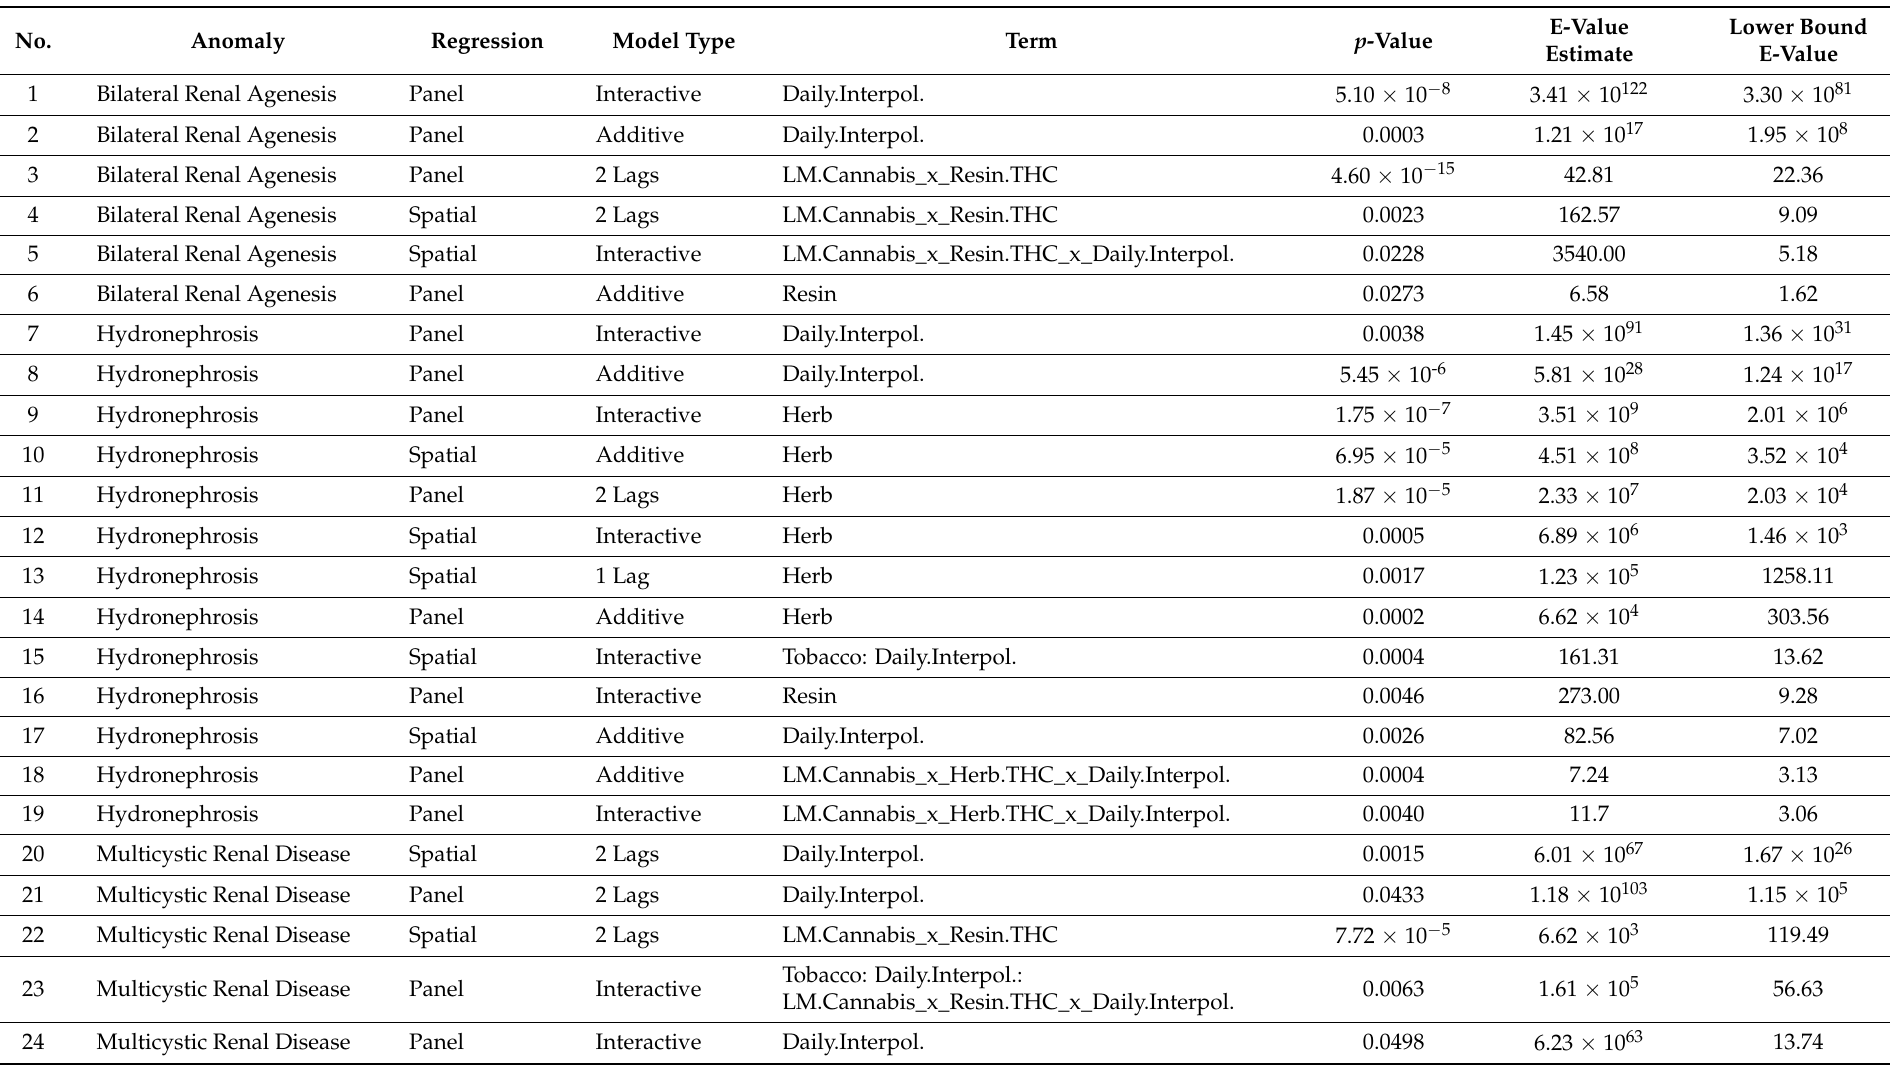
Table 11. E-Values by Anomaly.